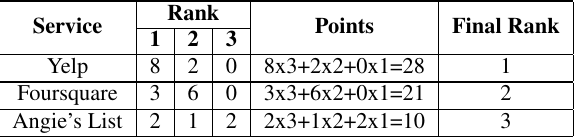
Table 2: Service ranking results for all the 14 users and Calculation of points for each ranked service using Borda counting to generate singe user provided baseline